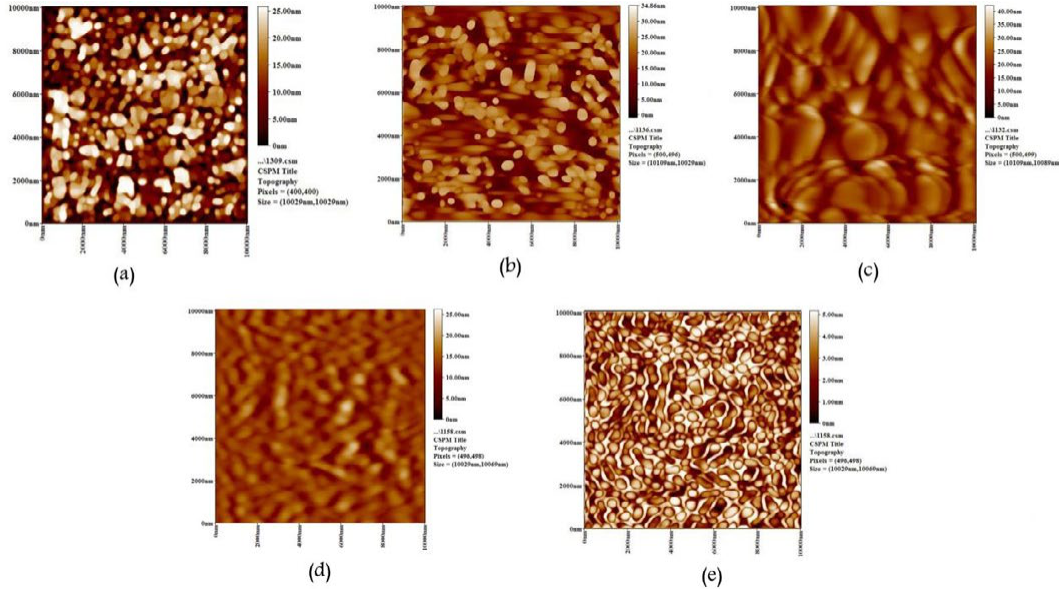
Fig. 1. AFM images of Y-PSZ with different MAS additives;(a) 5, (b) 10, (c) 15, (d) 20 and (e) 25 wt%.